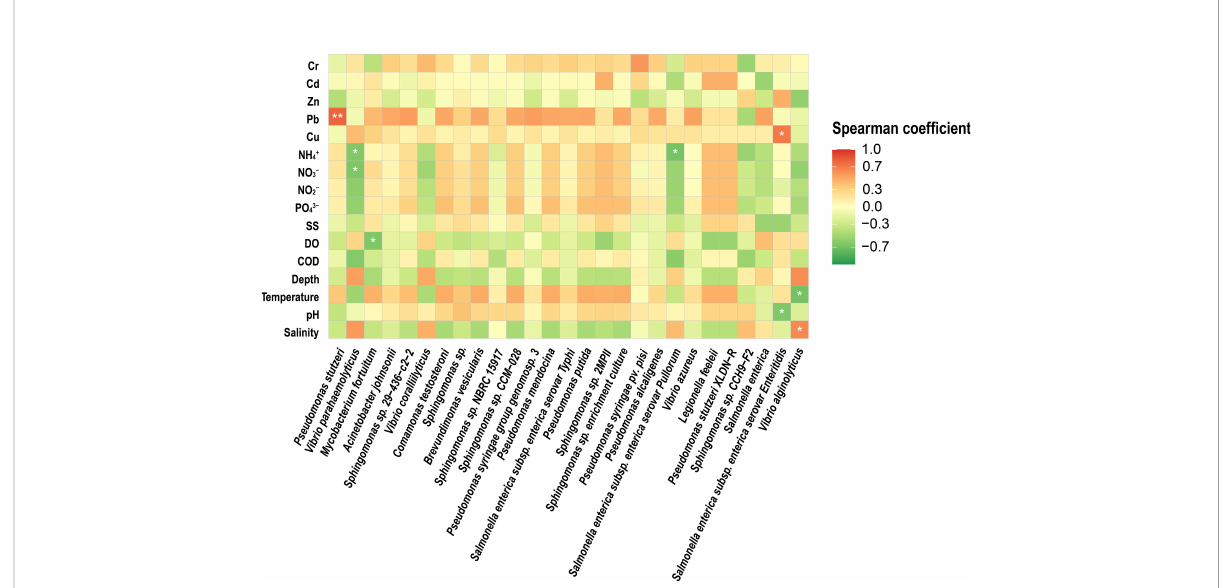
FIGURE 5 Heatmap showing the Spearman correlations between the 16S rRNA gene abundances of potentially pathogenic bacterial species and environmental variables in the studied estuary samples. *signi fi cant correlation at 0.05 level, **signi fi cant correlation at 0.01 level.